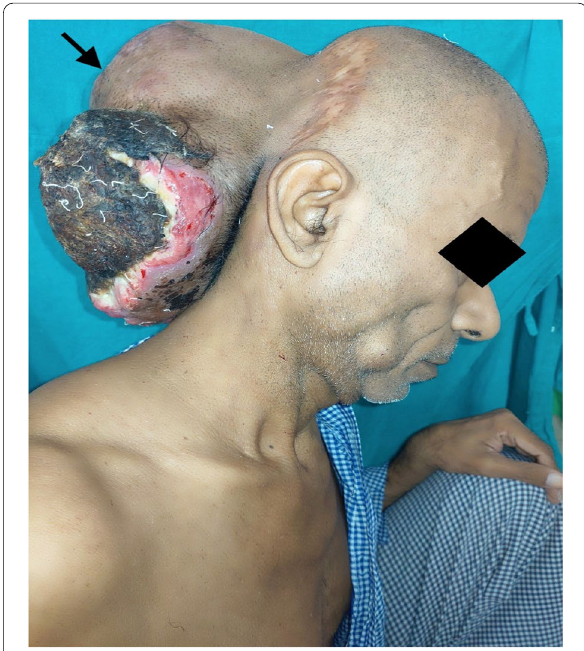
Fig. 1 Huge scalp swelling in the occipital